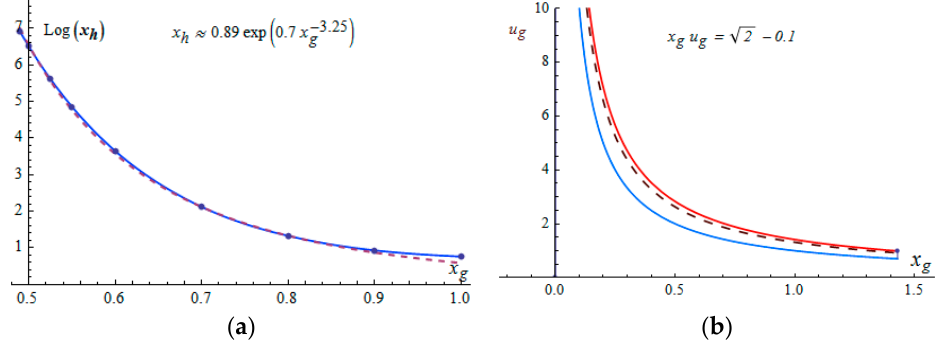
xx ( a ) along the dashed line 1.02 −= gh